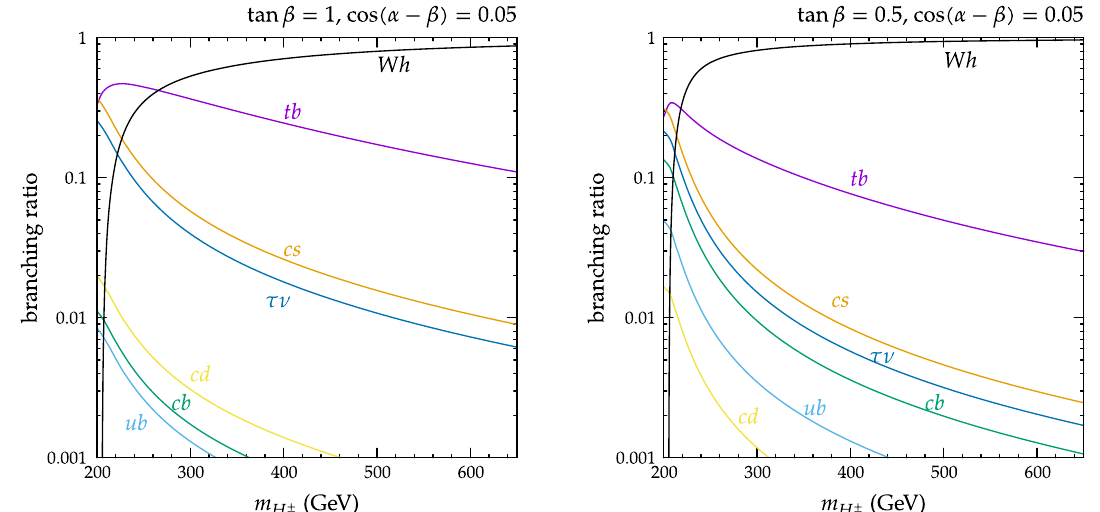
Fig. 11 Branching ratios of the heavy charged Higgs H ± . tan β = 1 (left panel) and tan β = 0 . 5 (right panel) have been taken. cos (α − β) = 0 . 05 = y SM and y u t for both 33